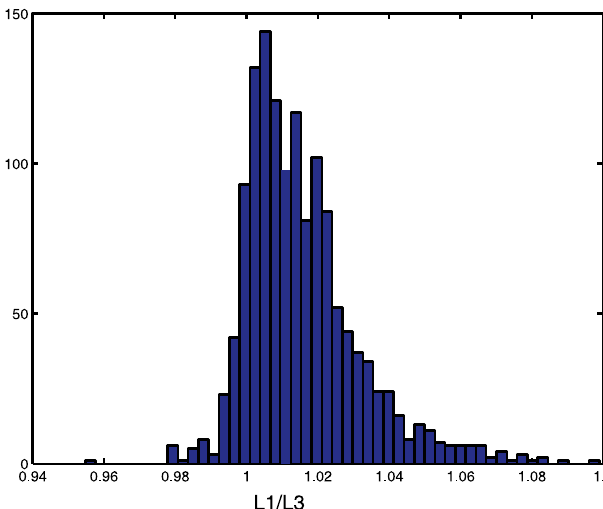
Figure 6. Histogram of Likelihood Quotients when Comparing Scenarios S 1 and S 3 DOI: 10.1371/journal.pcbi.0020046.g006